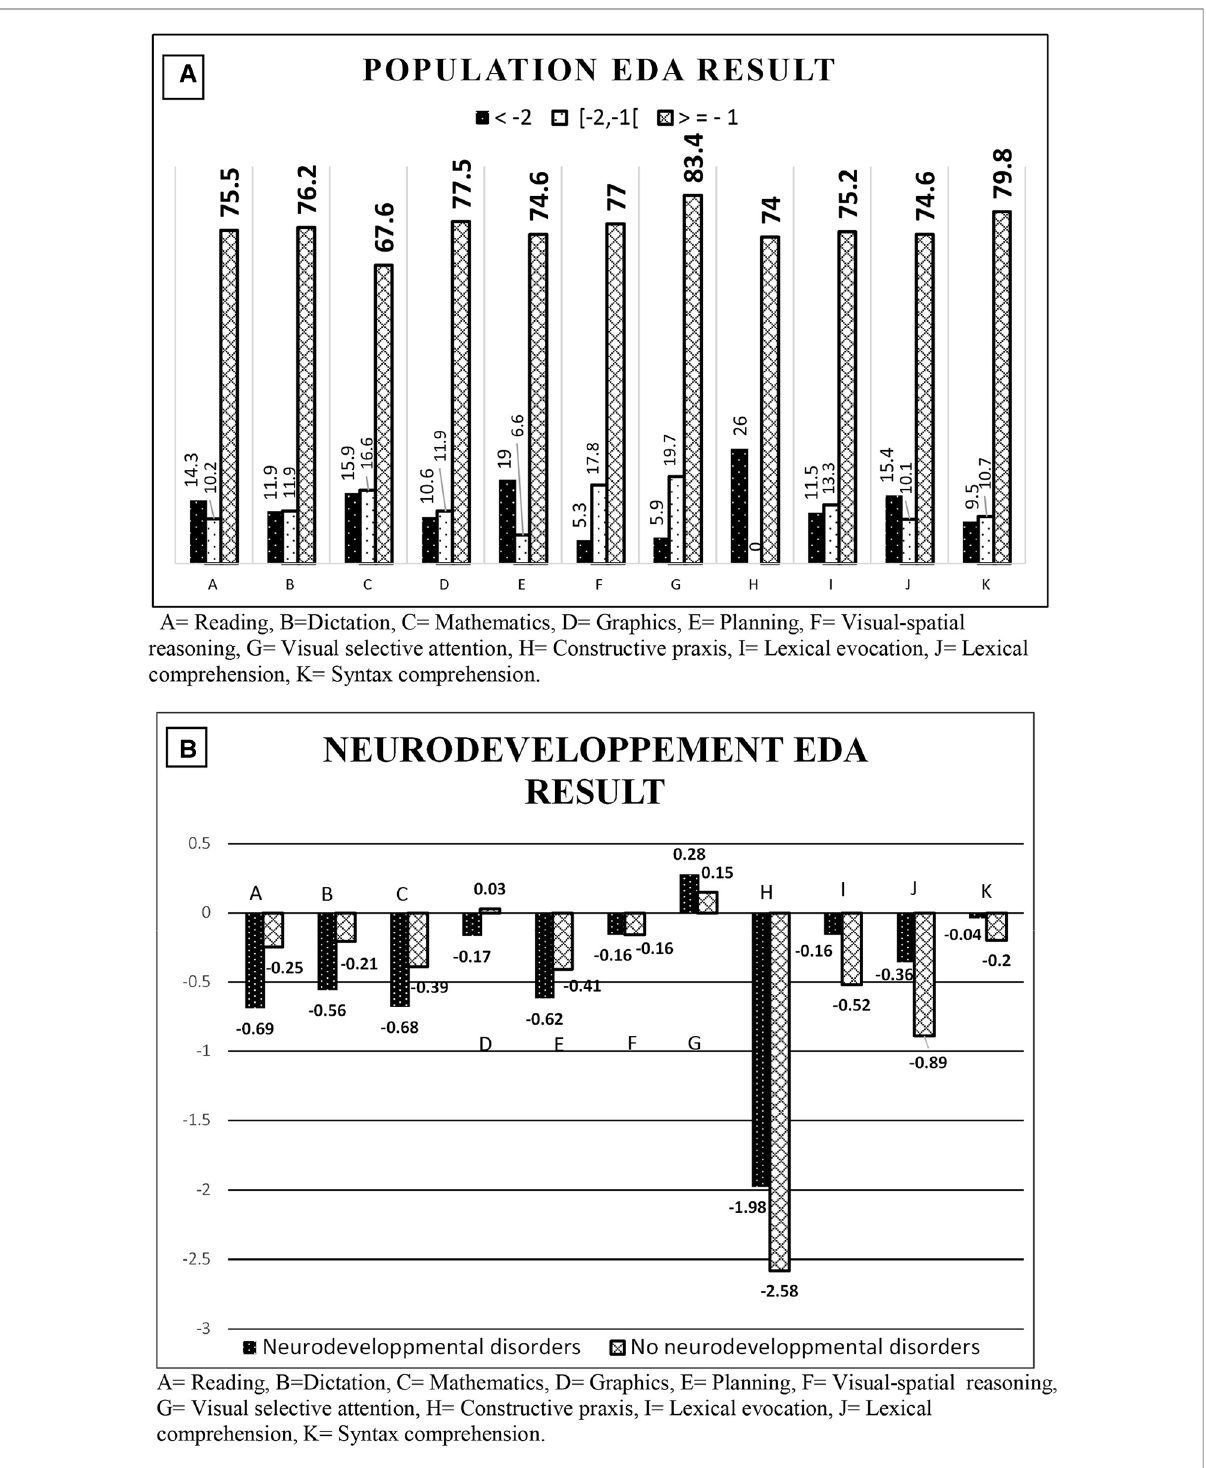
FIGURE 2 EDA Z-scores. ( A ) Percentage of population based on EDA Z-score. ( B ) Mean Z-scores for the EDA parameters of all grade levels based on neurodevelopmental